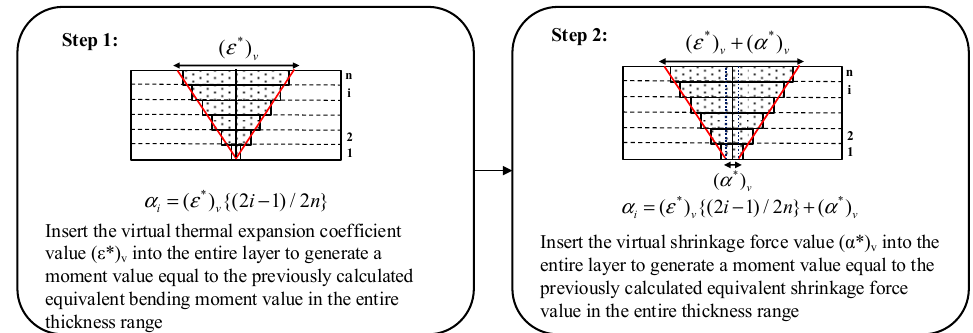
Figure 4. Procedure for adjusting input variables by introducing virtual thermal expansion coefficient value (( ε *)v) and virtual shrinkage force value (( α *)v).